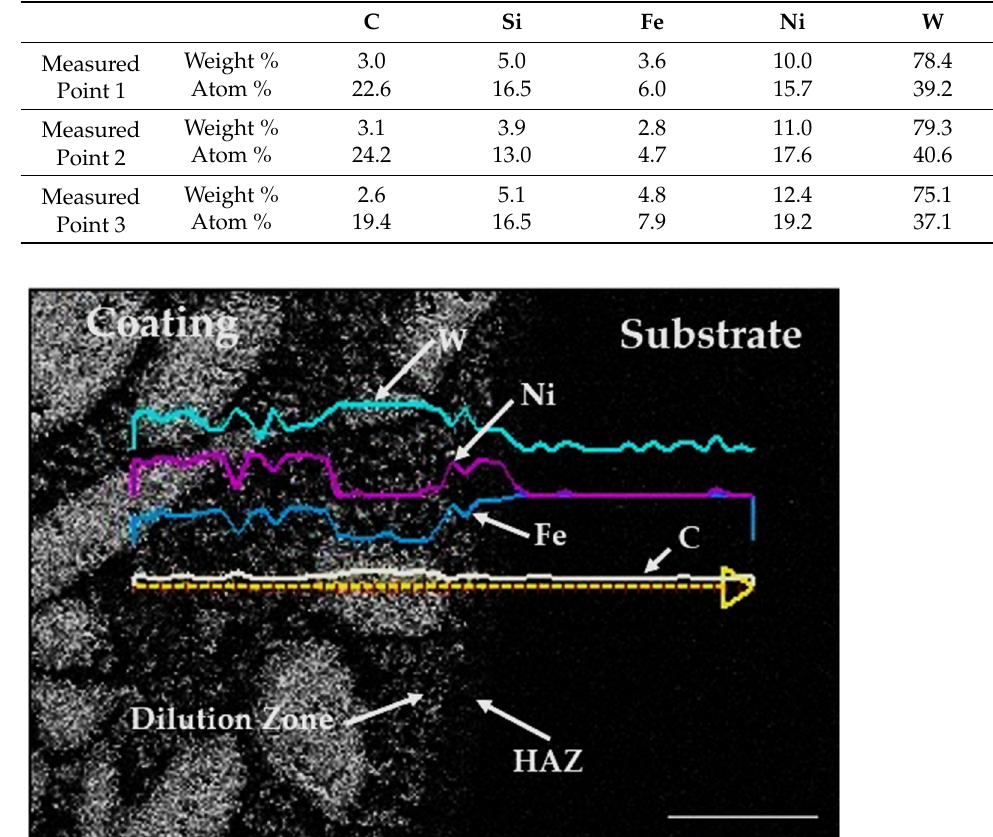
Table 6. Chemical composition in Weight % and Atom % of measured points of precipitation subjected